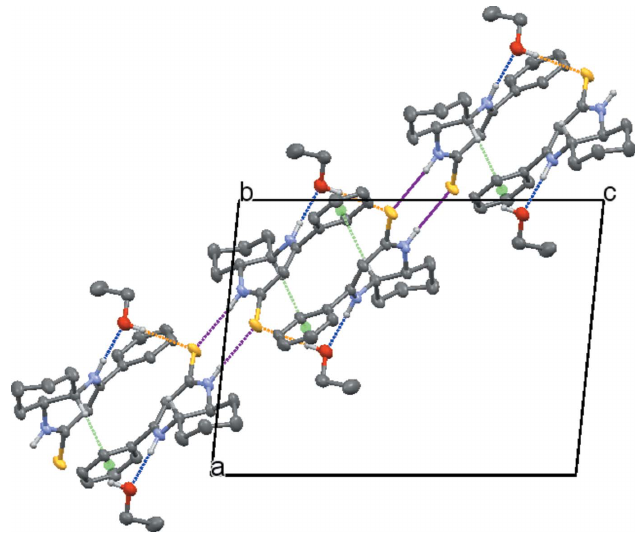
Figure 3 Packing viewed along the b -axis direction with the N—H (cid:2)(cid:2)(cid:2) S hydrogen bonds linking chains shown by purple dashed lines. Other intermolecular interations are depicted as in Fig. 2.